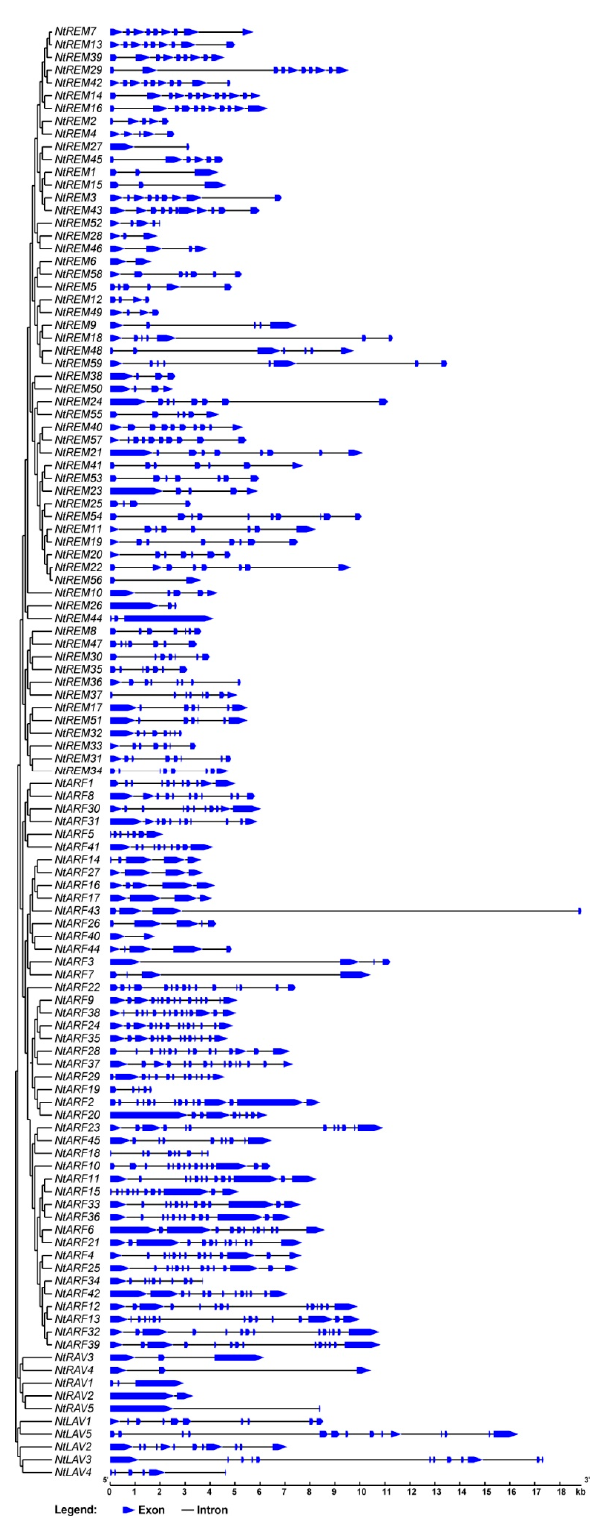
Figure 3. Gene structure analysis of 114 B3 genes in tobacco according to each family. Exons and introns are represented by colored boxes and black lines, respectively.